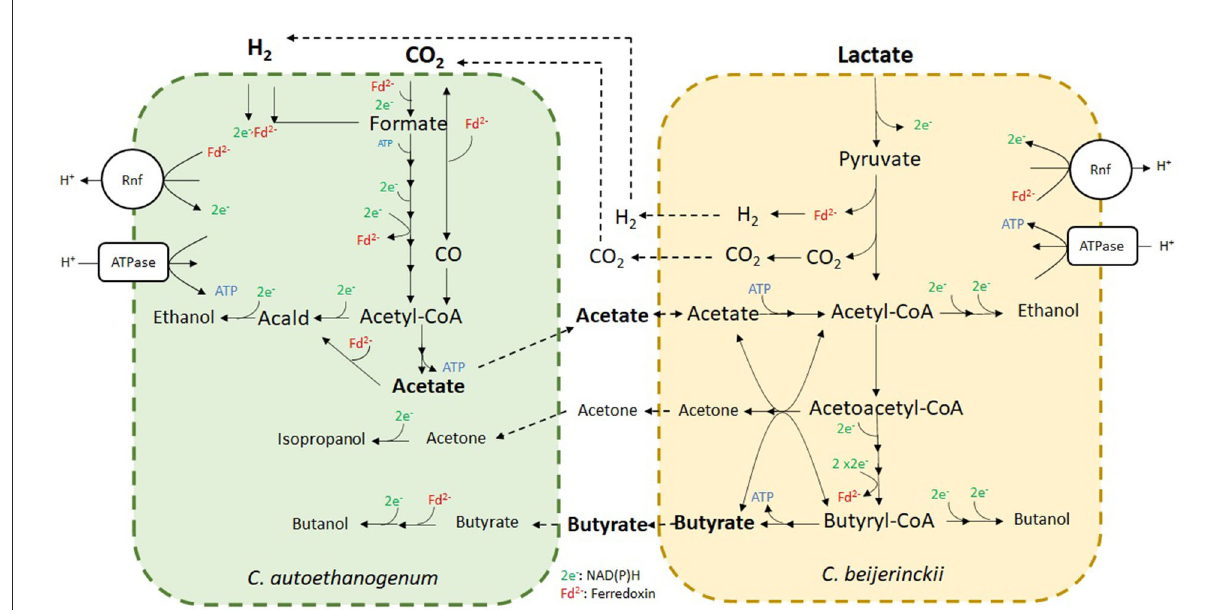
FIGURE9 Fermentation of CO 2 /H 2 and lactate by the novel co-culture of C. autoethanogenum and C. beijerinckii . Metabolites in bold indicate substrates and main products. Metabolites in smaller letter size indicate minor products. Arrows indicate the flux direction. Dashed lines display transport reactions of metabolites from the extracellular compartment to the intracellular compartment of the indicated microbe, and vice versa